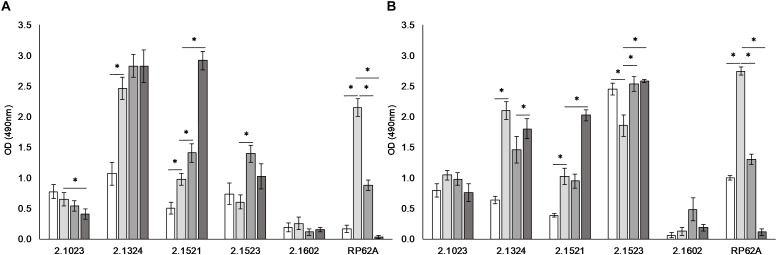
Biofilm formation is dependent on environmental conditions. Biofilm formation on hydrophobic (A) and hydrophilic (B) support when incubated in TSB (), TSB + 1% glucose (), TSB + 1% glucose + 3% NaCl (), and TSB + 1% glucose + lactate (pH 6) (). Significant differences of mean are marked by ∗. Mean ± SE.